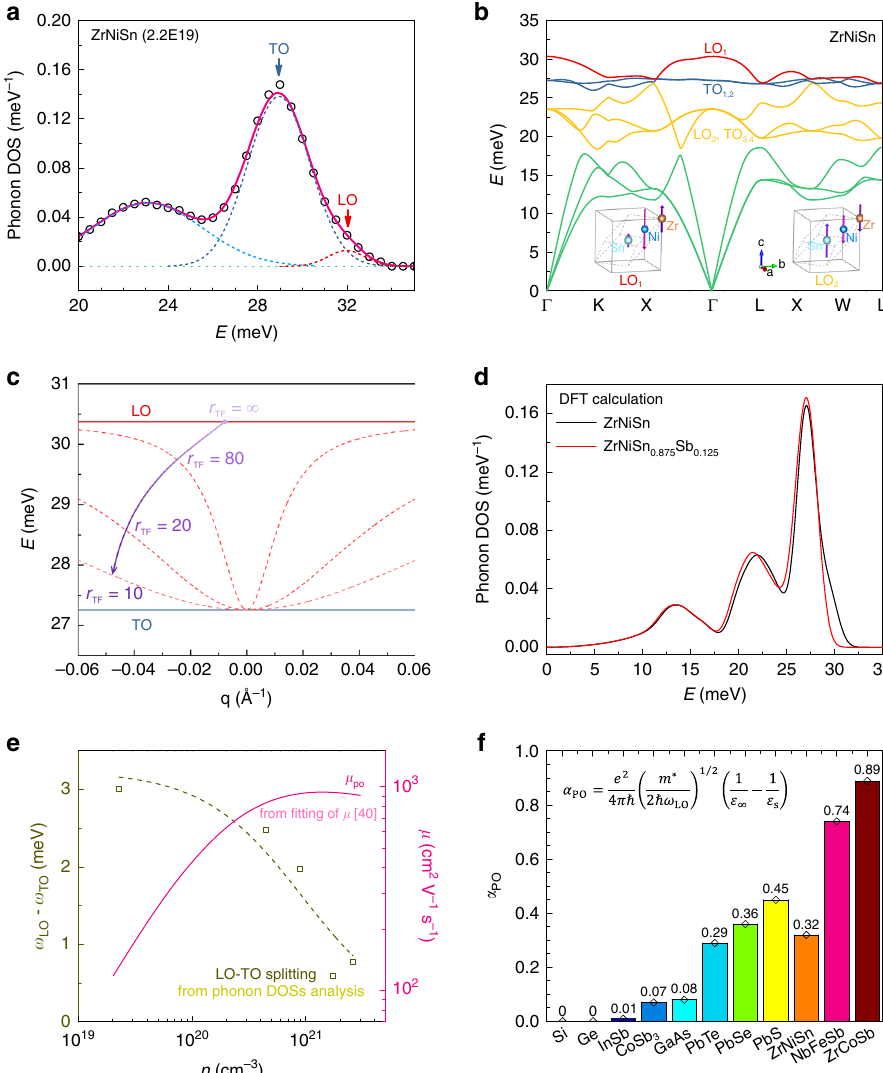
Fig. 4 Screening of the LO – TO splitting and polar optical scattering. a Decomposition of the optical phonon bands shows the LO – TO splitting. b Calculated phonon dispersion in ZrNiSn parent sample. The insets illustrate the phonon vibration modes for the two longitudinal optical phonons (a propagation vector along c axis is used here to de fi ne longitudinal and transverse phonon vibrations). The LO – TO splitting mainly occurs for the high- frequency optical branches of LO 1 and TO 1,2 . c Schematic illustration of the screening effect on the LO – TO splitting (following the Eqs. (2) and (4) in Methods) with different Thomas-Fermi screening lengths, r TF (in units of the lattice constant). With enhanced screening or smaller r TF as traced by the arrow, the LO frequency around the Brillouin zone center is suppressed. The Born effective charge, Z a , is supposed to be insensitive to the presence of free carriers, for this purpose, which is an approximation. d Comparison of the neutron-weighted phonon DOSs between ZrNiSn and ZrNiSn 0.875 Sb 0.125 calculated with fi rst principles. e Variation of the LO – TO splitting (or polarization fi eld) with n . The dash curve is fi tted using the Eqs. (2) and (4) in Methods including screening. The solid curve is the n -dependent mobility limited by polar optical phonon scattering in ZrNiSn 1 − x Sb x compounds 40 . With increasing screening, the LO – TO splitting and polarization fi eld are reduced, and the polar optical phonon scattering is reduced. f The polar coupling constant for some selected TE semiconductors as listed in Fig. 1. The value for the half-Heusler compounds is calculated based on the parameters as shown in Supplementary Table 1, while the data for other compounds is from literature 27